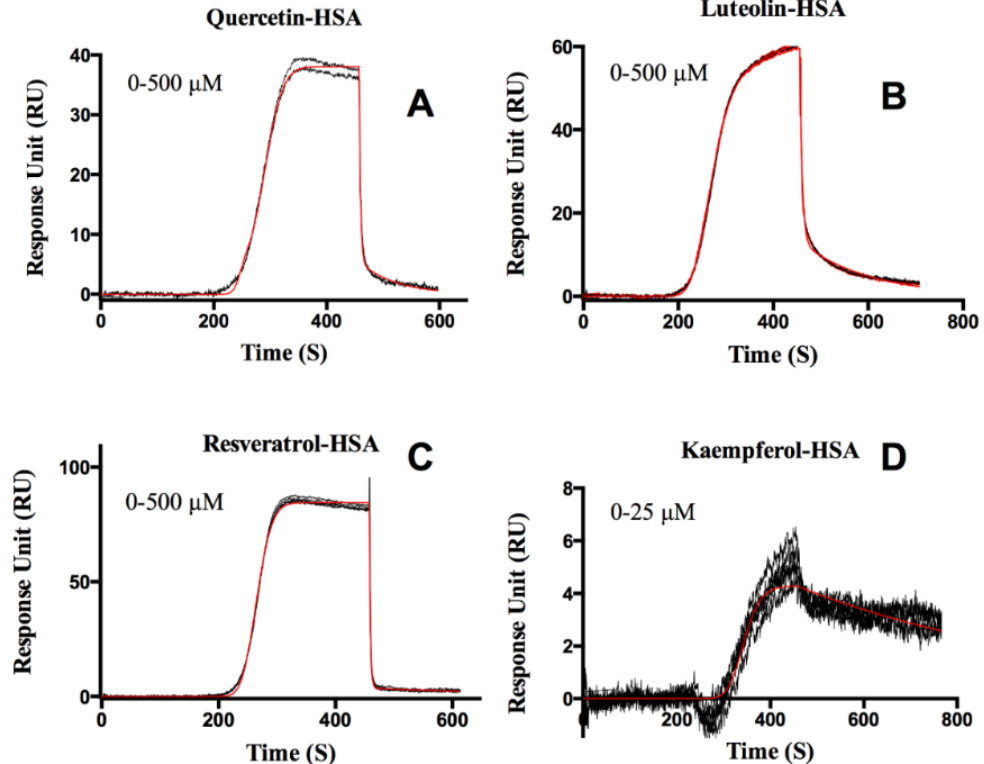
Figure 4. Sensorgrams of flavonoids (quercetin, luteolin, resveratrol, and kaempferol) interacting with HSA (Panels A – D ). The orange lines show global kinetic analysis model fit to the response data to extract binding constants using a 1:2 model (Panels A - C ) and a 1:1 model for panel D . The concentration range tested is indicated in each panel. The binding constants determined from the fits are listed in Table 1.